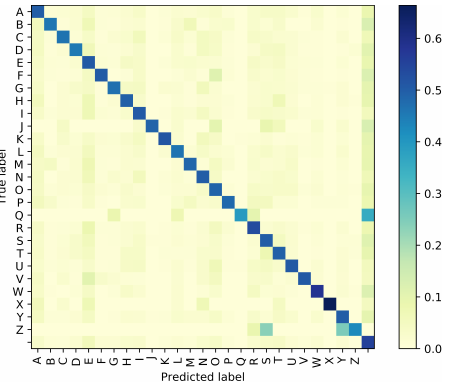
Figure 6. Confusion Matrix for GPT-based Iterator.